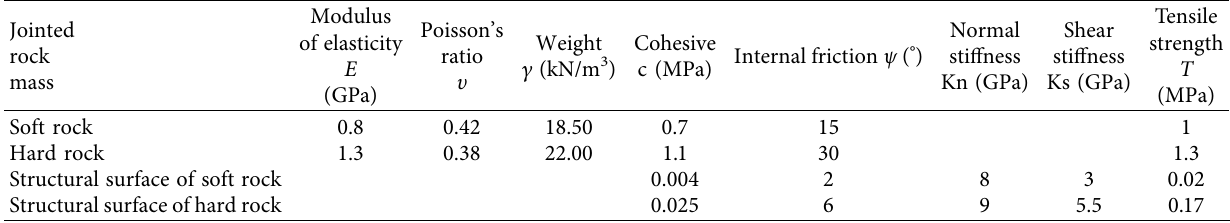
Table 2: Physical and mechanical parameters of the rock mass.